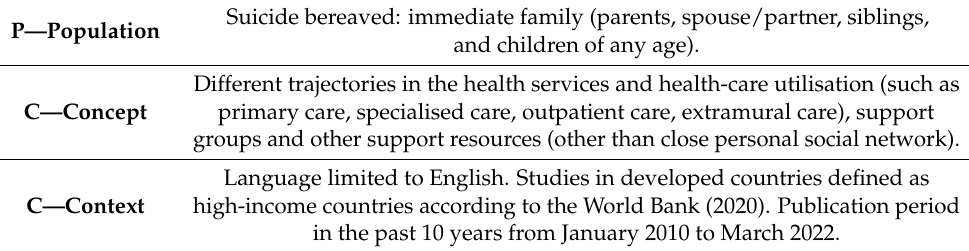
Table 1. Inclusion and exclusion